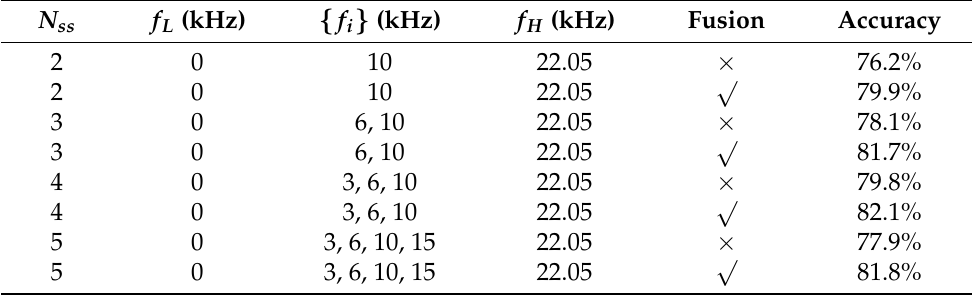
Table 4. Classification accuracy under different score level fusion